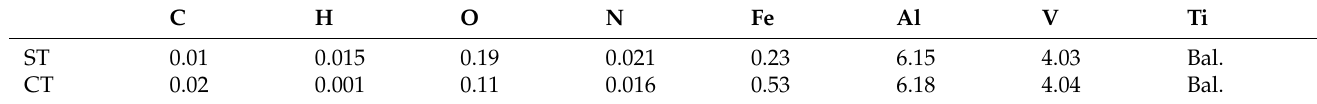
Figure 1. Size parameters of prepared titanium sheets. Table 1. Chemical composition (wt.%) of Commercial Casting Ti-6Al-4V and SLM-produced Ti-6Al-